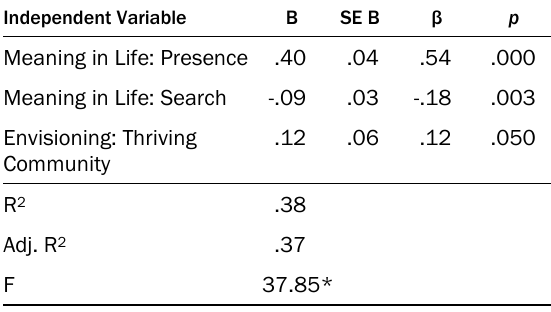
Table 13. Dependent Variable: Behavioral